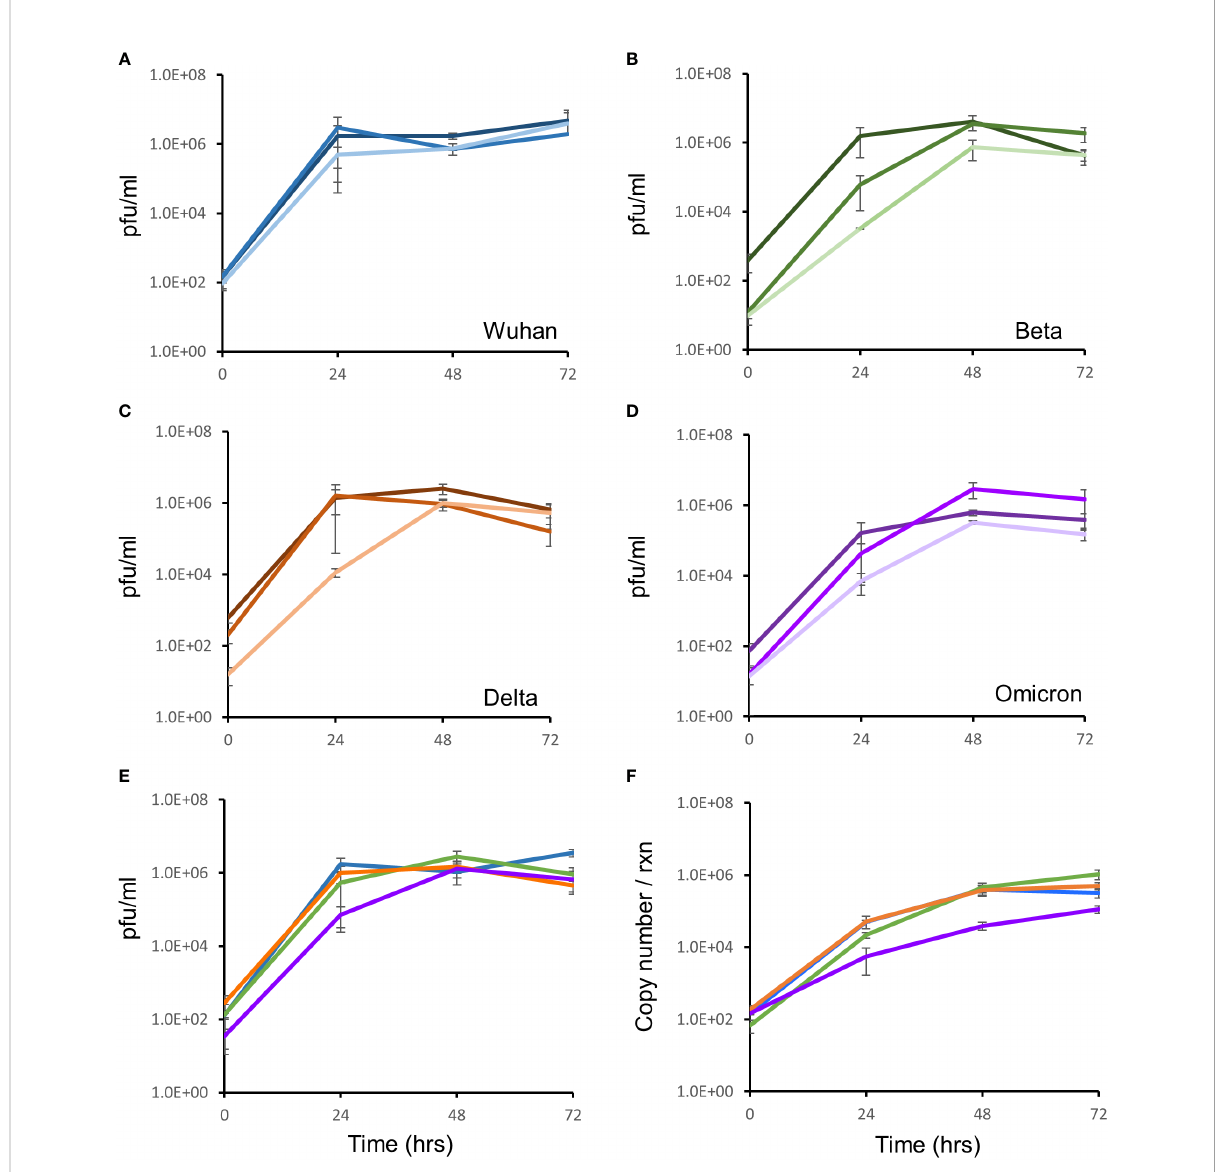
FIGURE 2 Growth kinetic assessment of the four SARS-CoV-2 variants. Vero E6 cells seeded at 1 x 105 cells/ml were infected after 24 hrs with three different isolates of the Wuhan strain (A) , Beta variant (B) , Delta variant (C) and the Omicron variant (D) . The 3 individual isolates for each variant in panels (A – D) are represented as the darkest to lightest colour shade (Blue for Wuhan; Green for Beta; Orange for Delta and Purple for Omicron). Growth of the virus was monitored over 72 hours by TCID assays. (E) Growth comparison, shown as an average of three biological repeats, of the four SARS-CoV-2 strains showed no difference in replication fi tness. (F) Growth was also monitored by quantitation of viral copy number per reaction, using qRT-PCR targeted to the E-gene, at the same timepoints. Strains are coloured according to shades used in panel (E) . Gene expression is an average of three biological repeats and error bars represent the standard error of the